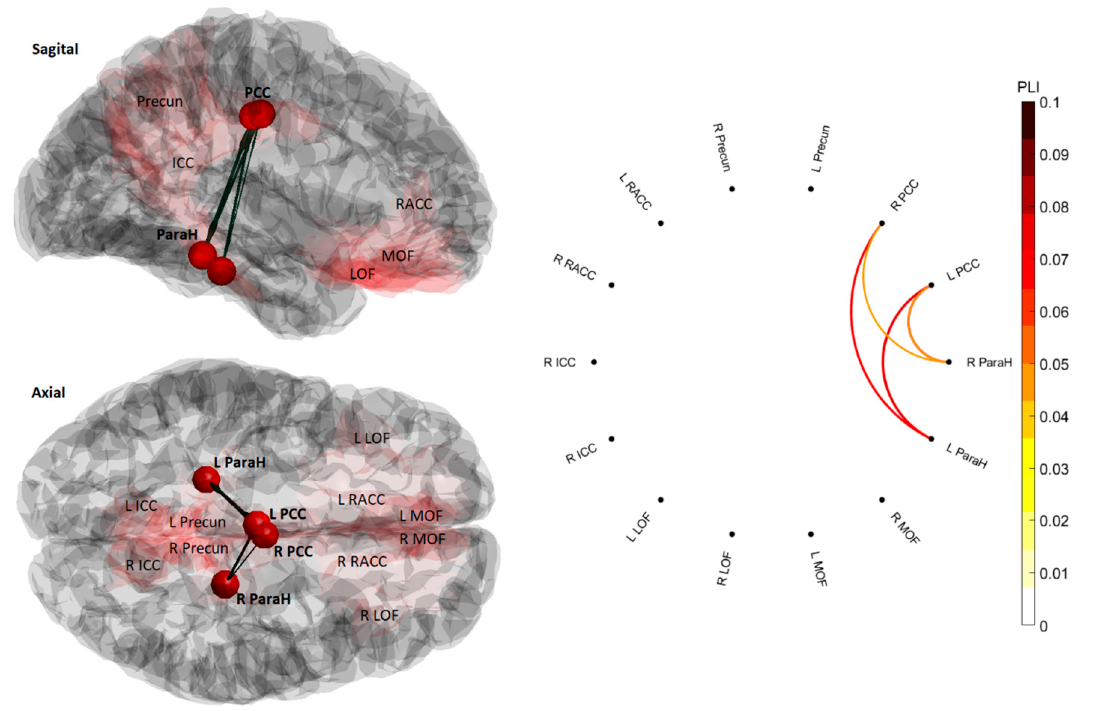
Figure 5. Illustration of the alpha functional connectivity change between brain regions following spinal manipulation (SM). The circular graph plot shows the phase lag index (PLI) of the functional connectivity post-SM. Greater values indicate higher PLI in the circular graph, located to the right in the figure. The visualization of the networks in the cortex shows the functional connectivity between the regions within the brain; red highlighted areas include the default mode network (DMN) with labels to illustrate localization within brain regions. The red dots in the cortex visualization represent the brain regions, which show significant results with bold labels, while the lines connecting them represent the functional connectivity from the PLI metrics, between brain regions. Left medial orbitofrontal (L MOF), right medial orbitofrontal (R MOF), left lateral orbitofrontal (L LOF), right lateral orbitofrontal (R LOF), left parahippocampal (L ParaH), right parahippocampal (R ParaH), left isthmus cingulate cortex (L ICC), right isthmus cingulate cortex (R ICC), left precuneus (L Precun), right precuneus (R Precun), left posterior cingulate Cortex (L PCC), right posterior cingulate cortex (R PCC), left rostral anterior cingulate cortex (L RACC), and right rostral anterior cingulate cortex (R RACC).